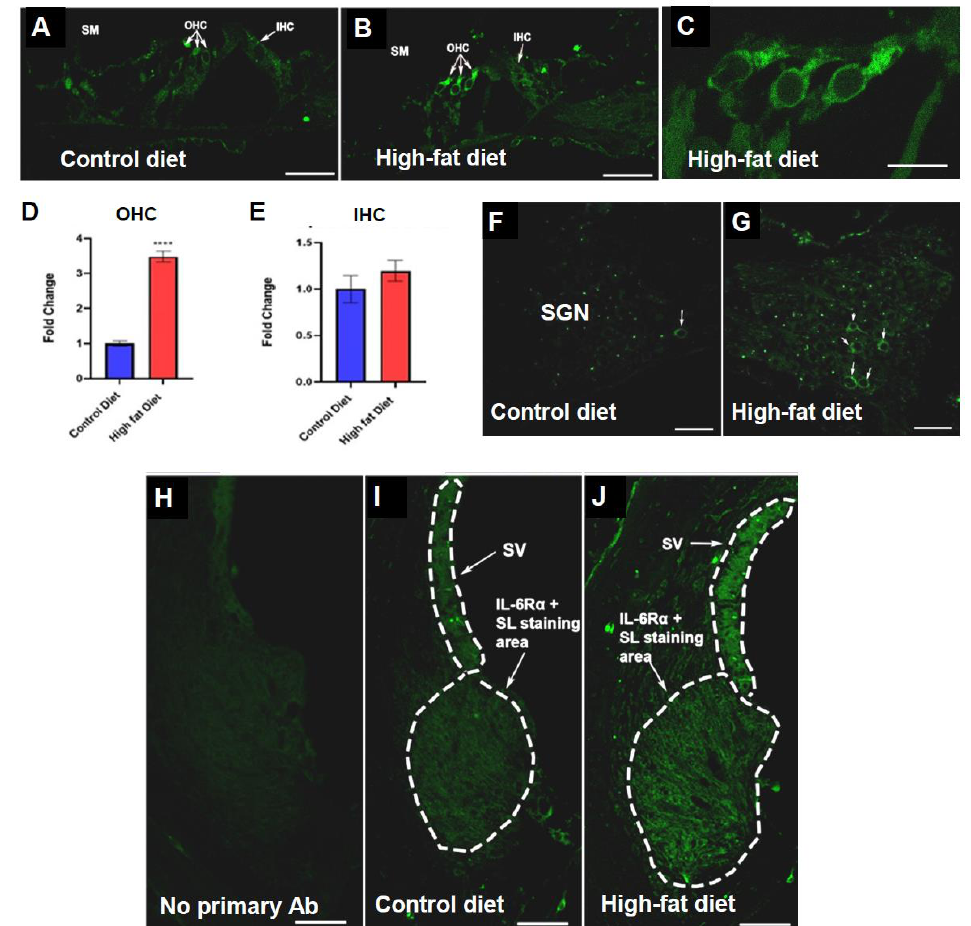
Figure 2. IL- 6Rα immunofluorescence in the mouse cochlea. ( A , B ) immunostaining in the organ of Corti (OoC). ( A ) Weak IL- 6Rα immunofluorescence was detected in the sensory and supporting cells of the OoC in mice on the control diet (CD). ( B , C ) In mice on HFD, IL- 6Rα immunofluorescence was intense in the outer hair cells (OHC). ( D ) Semi-quantitative analysis of immunofluorescence intensity in OHC showed a 3.5 fold increase in mice on a high-fat diet (HFD), whilst the immuno- fluorescence intensity in the inner hair cells (IHC) was similar in CD and HFD mice ( E ). Data pre- sented as mean ± SEM ( n = 5 per diet group). **** p < 0.0001, t -test. ( F , G ) In the spiral ganglion, more neurons expressed IL- 6Rα in mice on HFD (arrows). ( I , J ) IL- 6Rα immunofluorescence was observed in lateral wall tissues (stria vascularis and the spiral ligament) in both diet groups, whilst the back- ground signal was very low in control cochlear cryosections ( H ). The area and intensity of immu- nofluorescence were slightly increased in the lateral wall of the mice on HFD, but this was not sta- tistically significant. Scale bars, 30 μm ( A , B , F , G ); 10 μm ( C ); 50 μm ( H – J ).